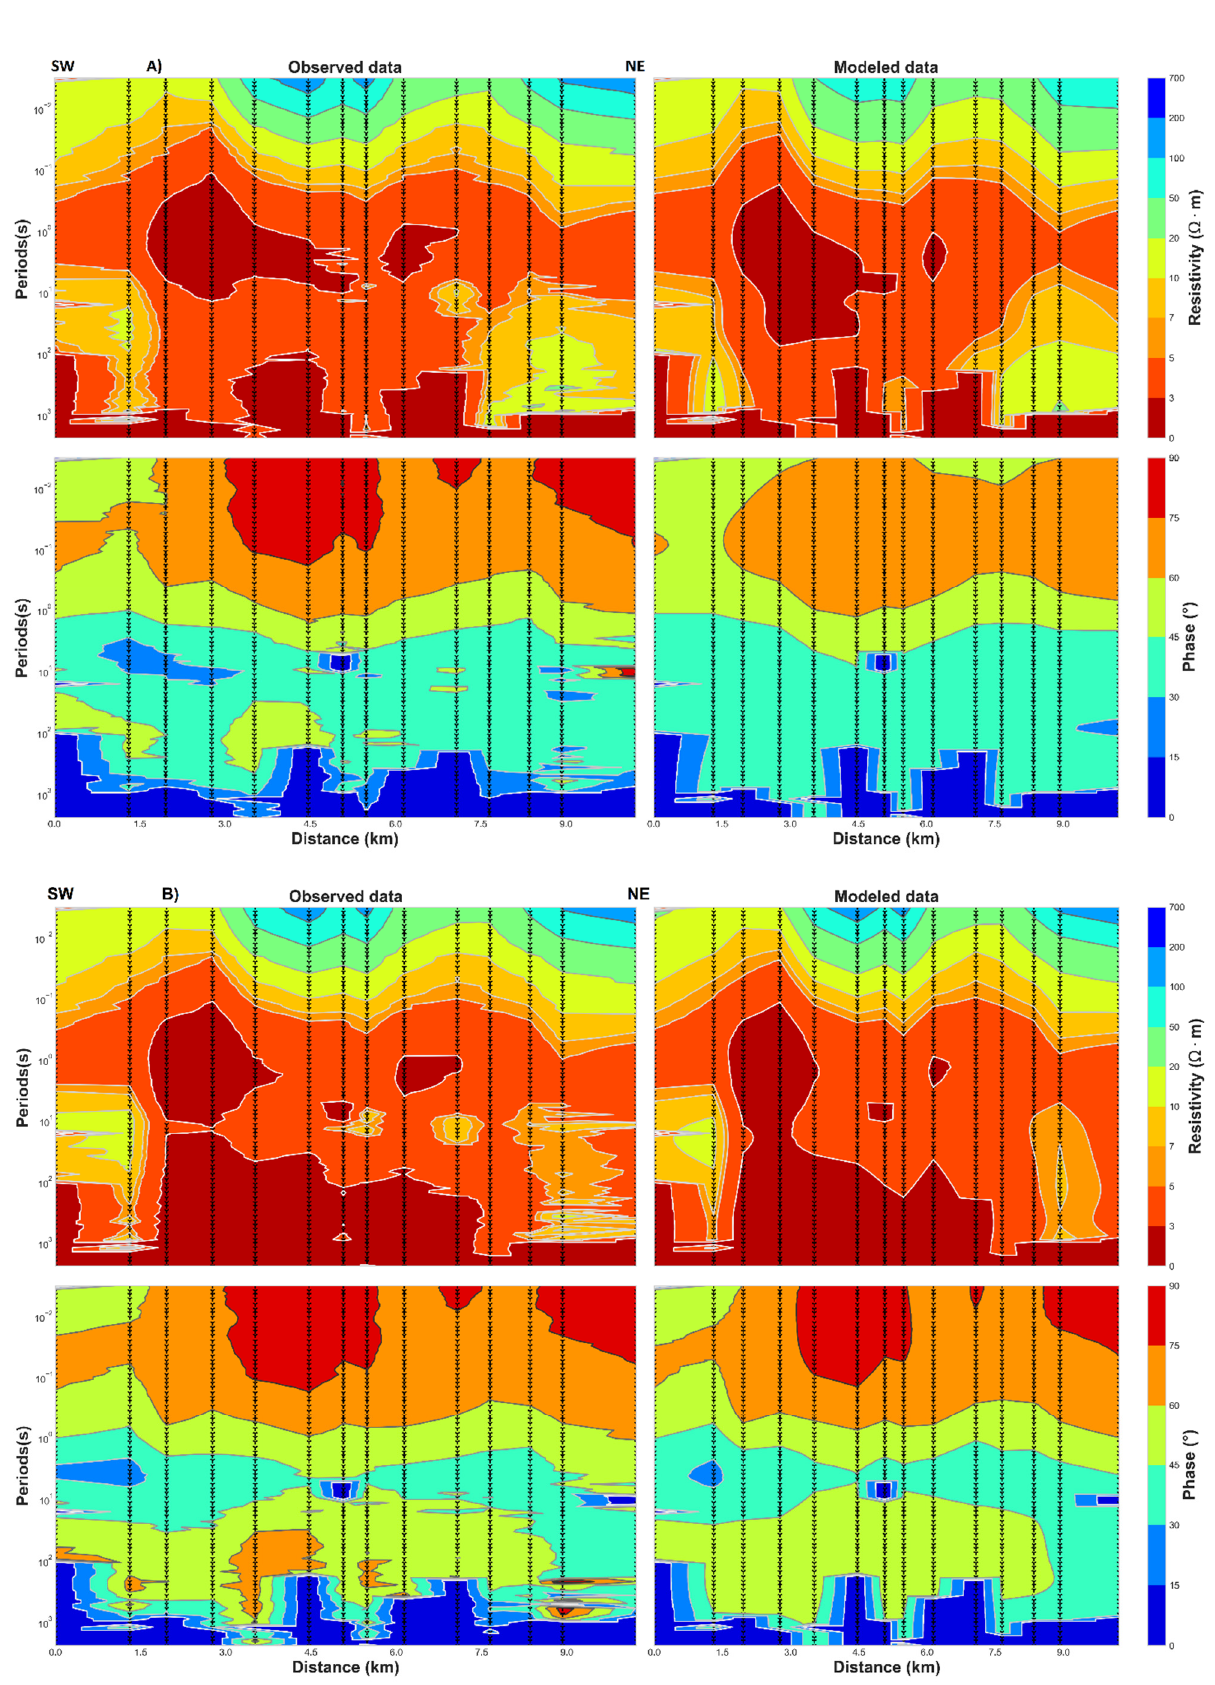
Figure 10. Observed vs. modeled apparent resistivity and phase data. ( A ) for the TM data and ( B ) for TE − TM data.